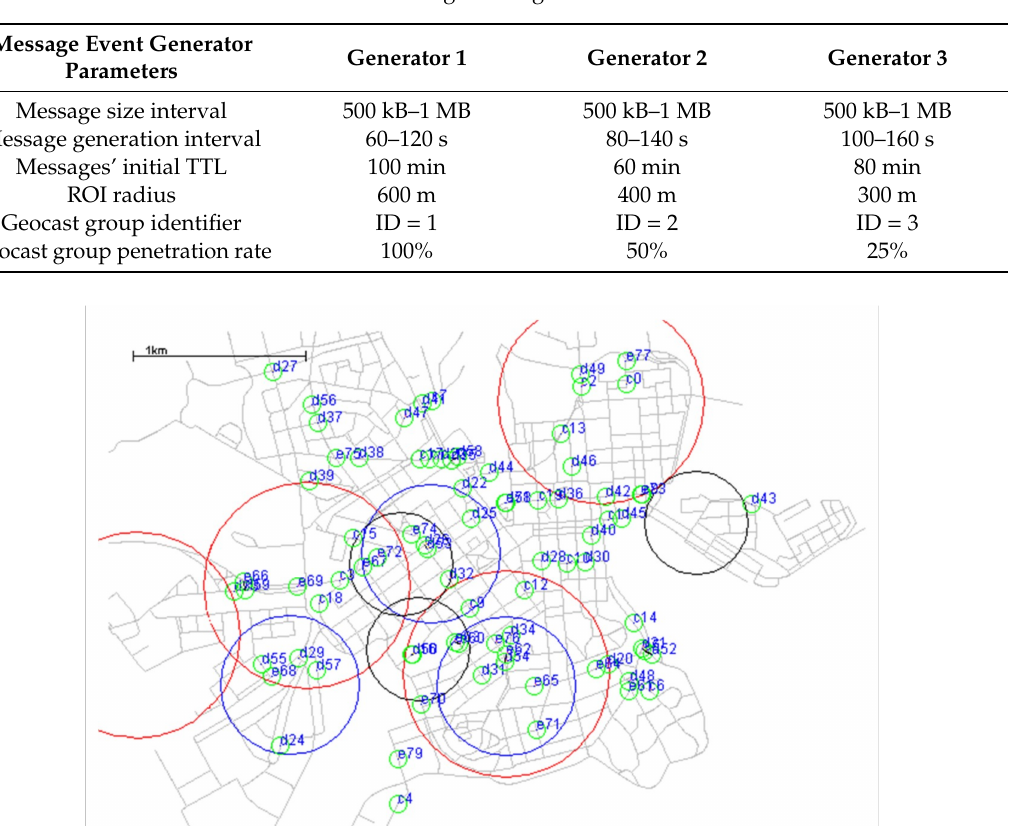
Table 4. Parameters for the distinct message event generators used in the Helsinki scenario.